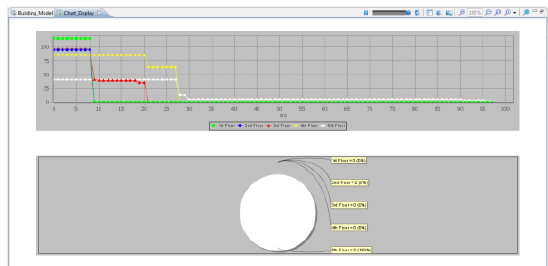
Figure 10. A screen capture image of the PEOPLE agents population chart at time = 96 seconds